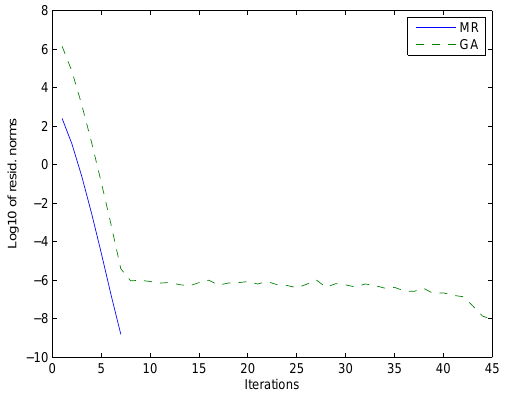
Figure 2. GA: dashed line, MR: solid line.